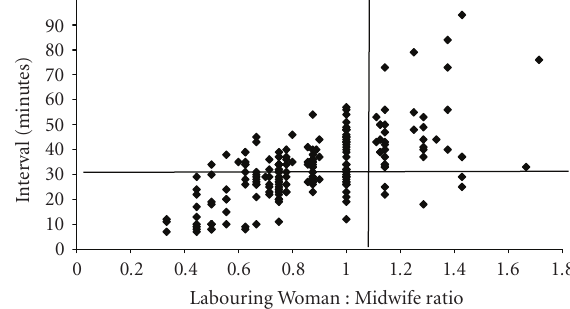
Figure 6: Decision-to-delivery interval versus Labouring Woman: Midwife ratio (grade